Question: In one sentence, what is this figure communicating?
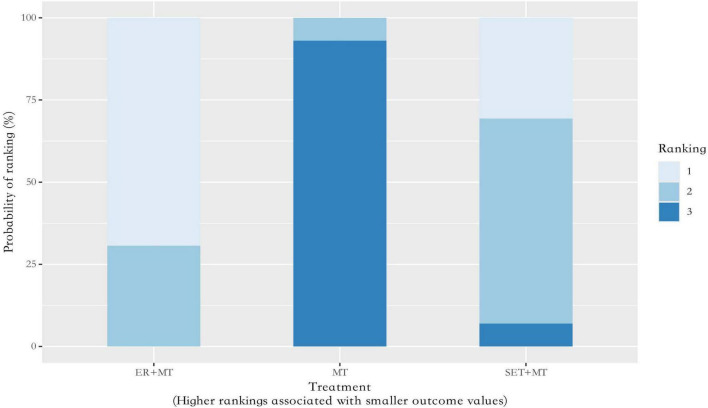
Answer: Ranking probability distribution for cerebral infarction incidence. Lighter colors represent higher treatment rankings and lower cerebral infarction risk.